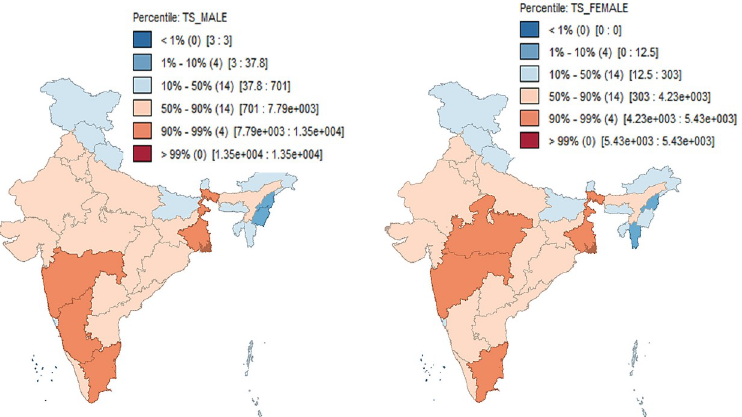
Fig 2. Percentile distribution of total male (left) and female (right) suicide incidences in India for the year 2018.